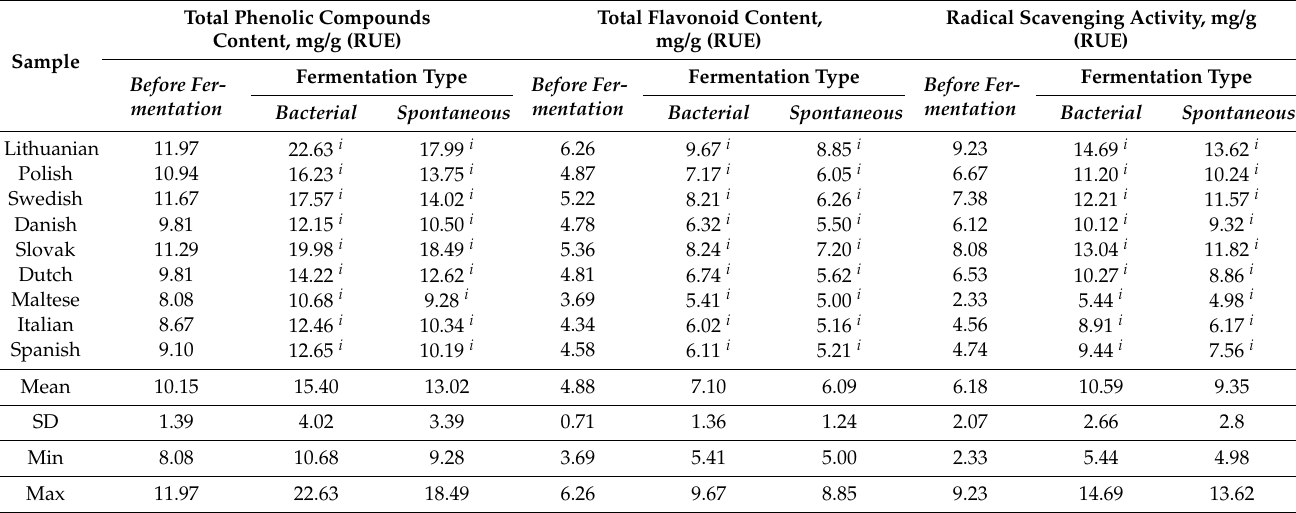
Table 4. Changes of total phenolic compound content, total flavonoid content and radical scavenging activity of pollen samples before and after